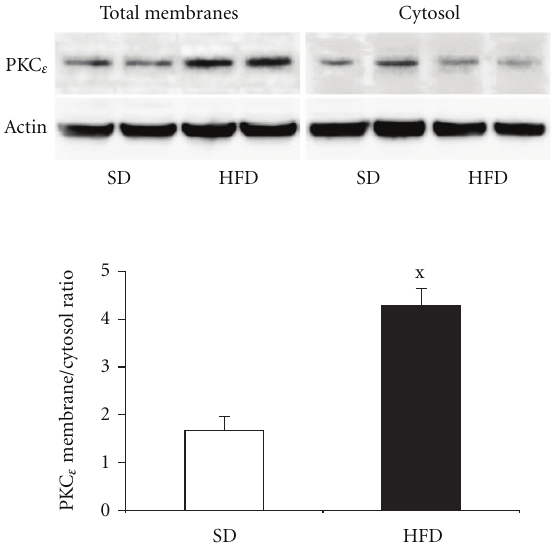
Figure 7: The e ff ect of hepatic fat accumulation on PKC ε activation. Representative Western blot is shown in the upper part of the figure; TM, total membrane fraction, C, cytosol fraction. The PKC ε membrane to cytosol ratio is shown in the graph. The relative densities of the bands in the membrane fraction were compared with corresponding ones in cytosol fraction in order to obtain the measurable parameter of activation. Values represent means ± S.E.M. of 7 animals. x P < 0 .